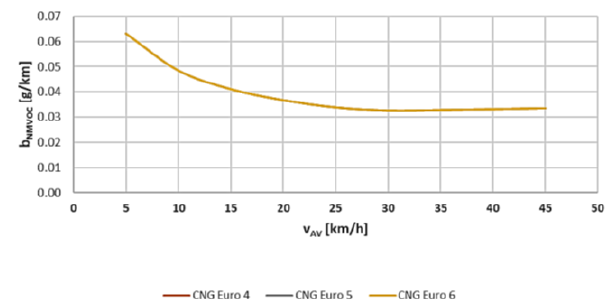
Fig. 23. NMVOC emission from CNG PCs for Euro standards depending on average speed